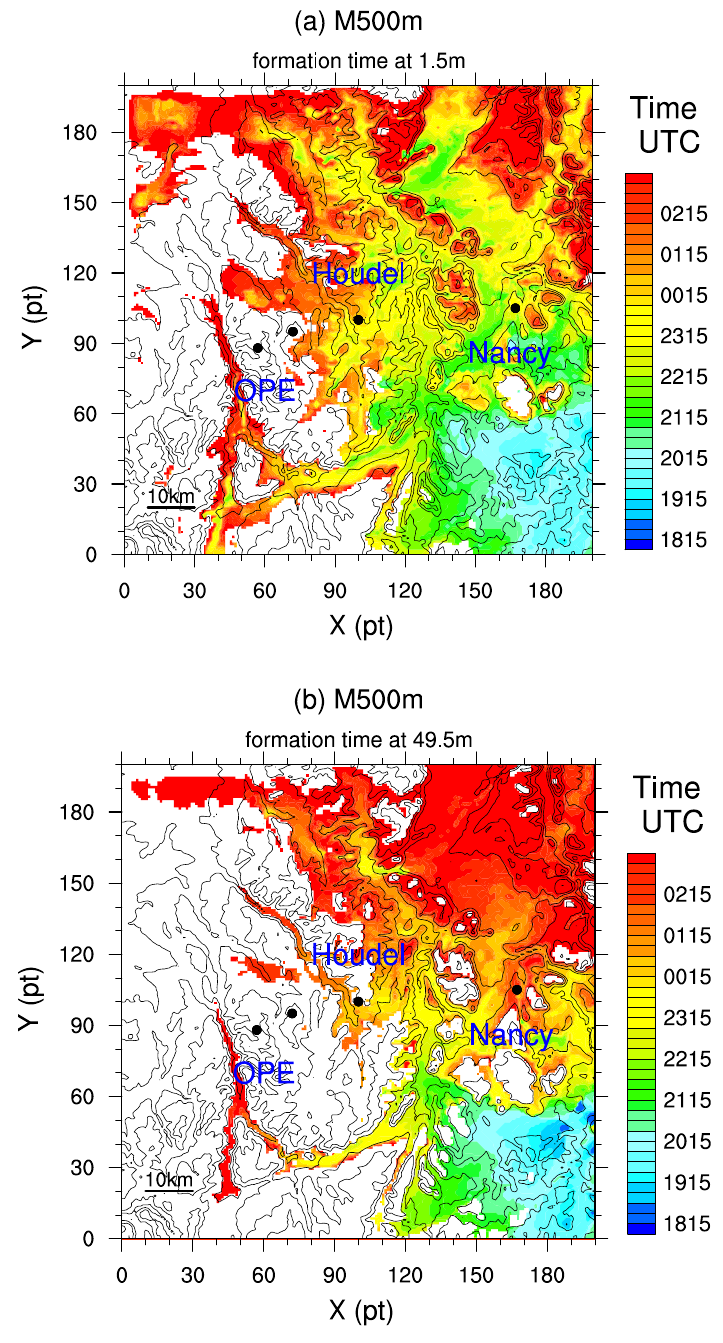
Figure 4. Fog onset time (UTC) at ground level ( a ) and at 50 m ( b ) for the M500m model superimposed with the topographical features (contours every 50 m). The black dots indicate the locations of the observation